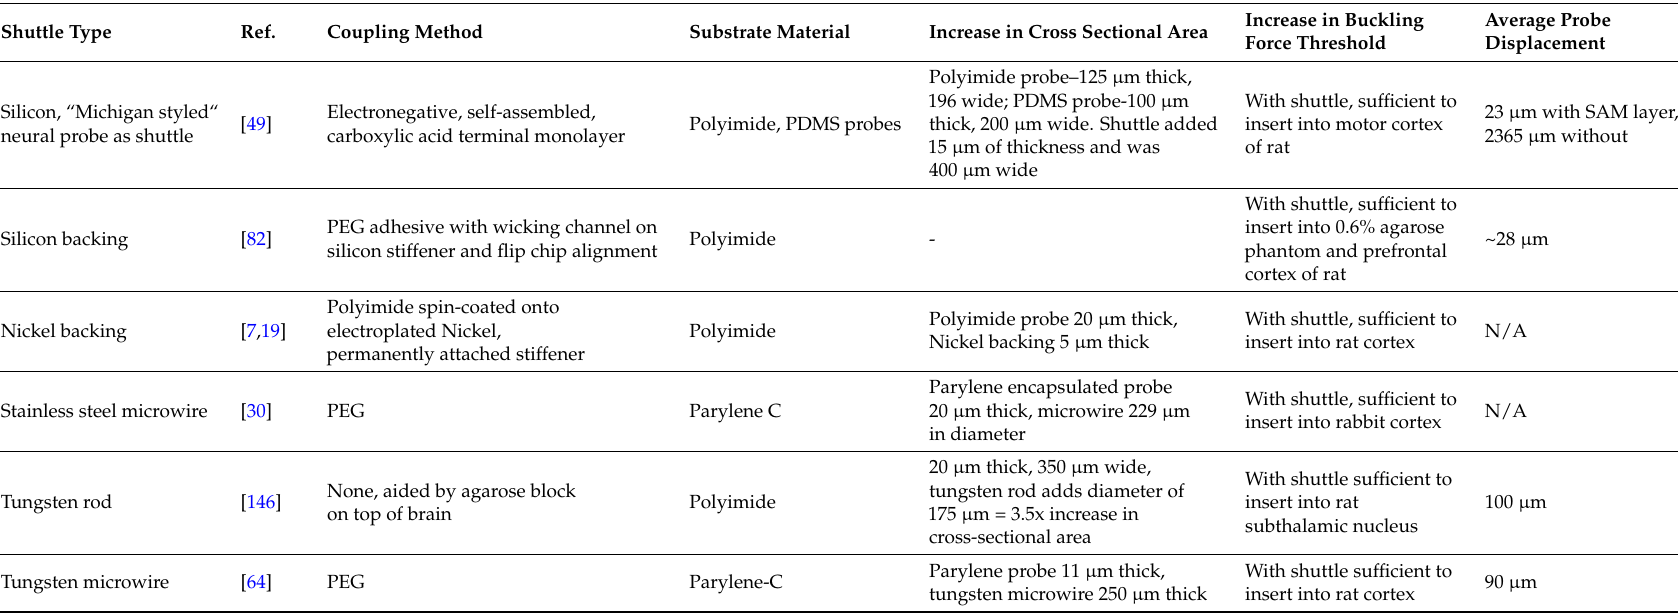
Table 4. Shuttle-based solutions for stiffening flexible probes during insertion. SAM: Self-assembled monolayer; PEG: Polyethylene